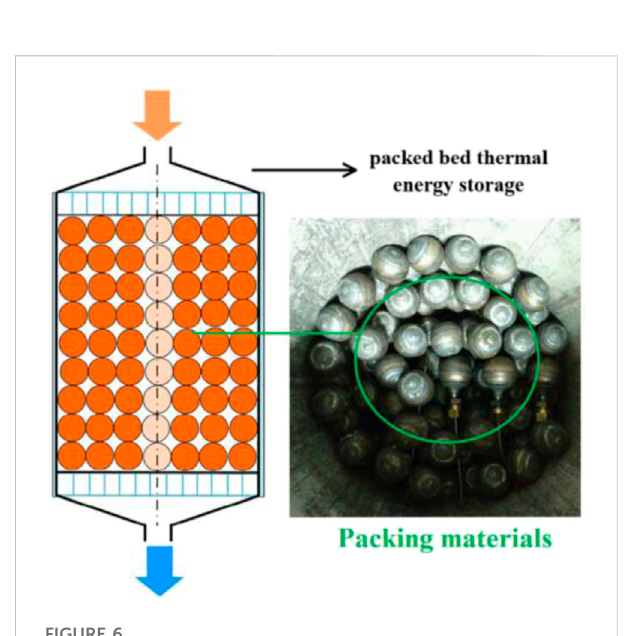
FIGURE 6 Packed bed TES system and PCM (Li et al., 2018c). License Number: